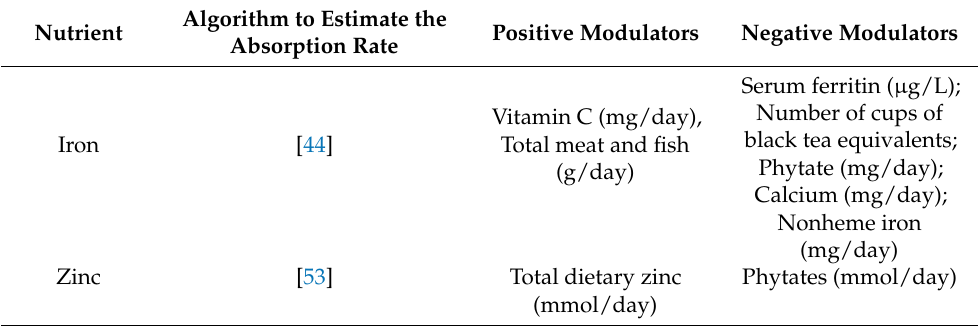
Table 1. Positive and negative modulators used in algorithms to assess the iron and zinc bioavailabil- ity in individual